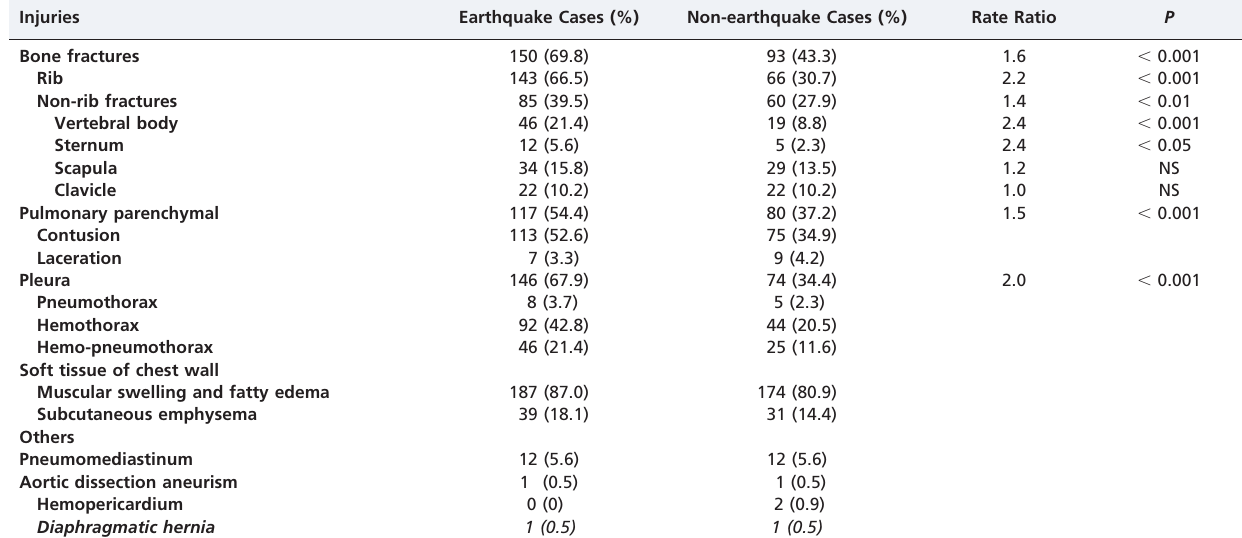
Table 1 - Conditions Observed in the Earthquake-related Thoracic Crush Traumas and Non-earthquake Traumas.